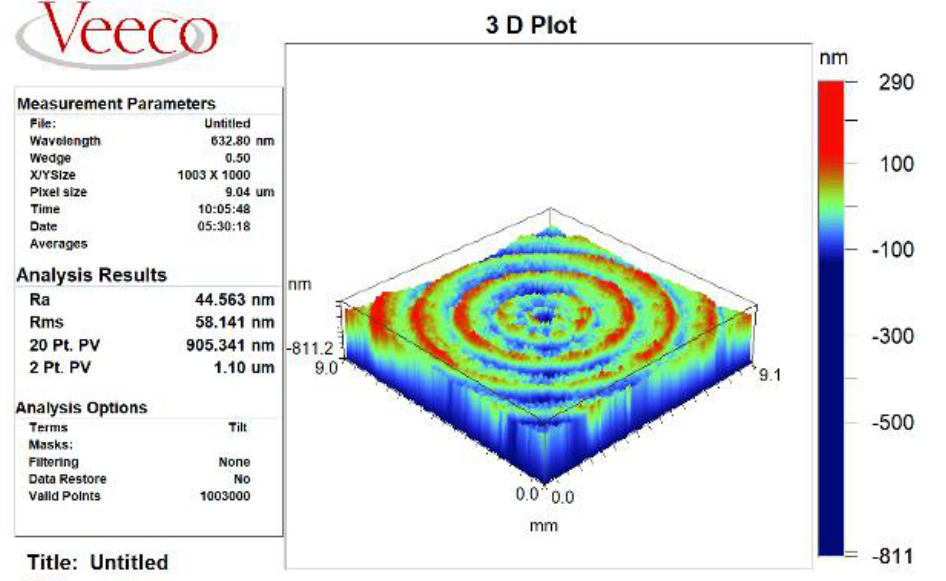
Figure 11. Testing results of the workpiece surface topography.